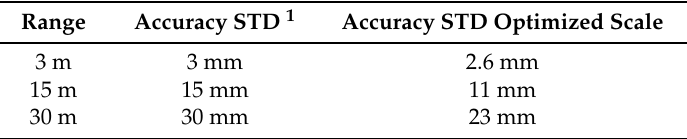
Table 1. EyesMap (EM) precision specified by the manufacturer.